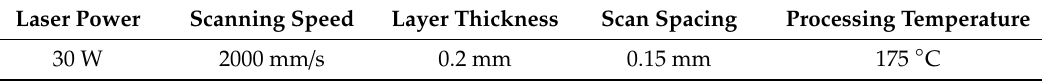
Figure 2. Schematic diagram of the SLS process. Table 1. Main parameters of the selective laser sintering (SLS)